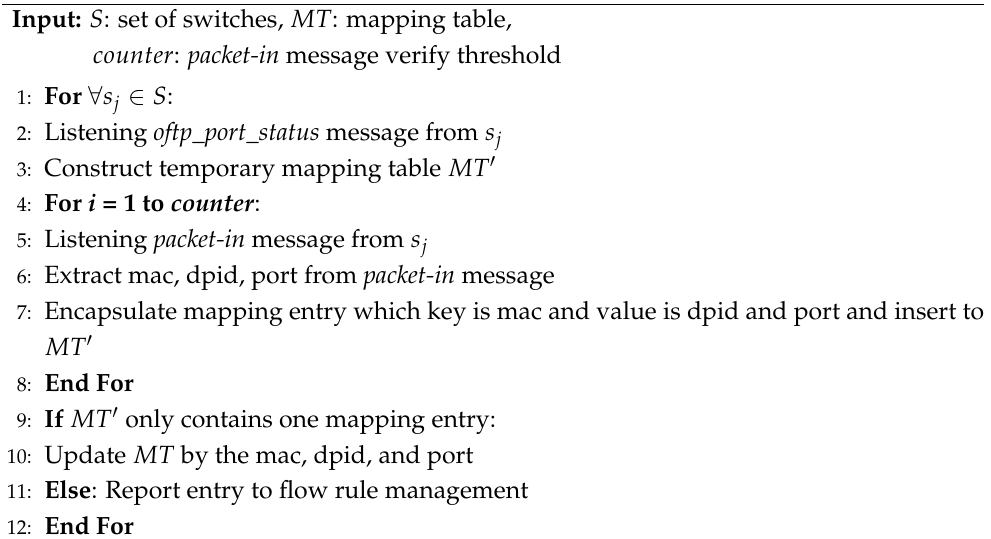
Algorithm 2 Port-Status Message